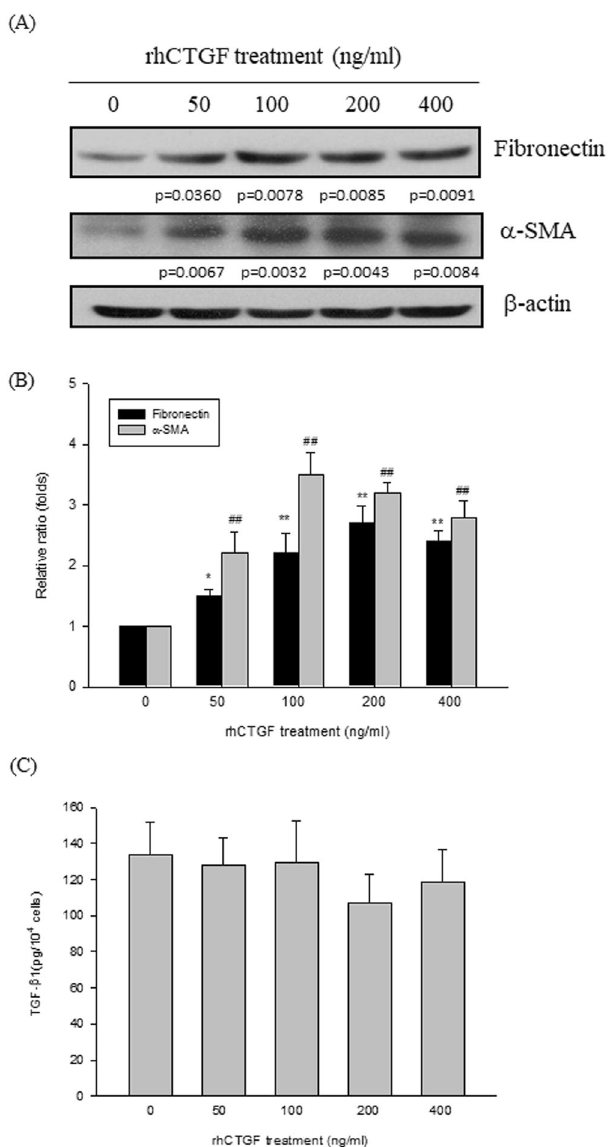
Figure 4. CTGF induced the fibronectin and α -SMA proteins expression in GO orbital fibroblasts. ( A ) After treatment of the orbital fibroblasts from GO1 patient with 50, 100, 200 and 400 ng/ml recombinant human protein CTGF (rhCTGF) for 24 hours, the proteins expression of fibronectin and α -SMA were examined by Western blots. ( B ) The representative bar graphic was constructed by the data obtained from three independent experiments, and data are presented as means ± S.D. ( * p < 0.05; ** and ## p < 0.01). ( C ) By an ELISA kit, the intracellular levels of TGF- β 1 in the orbital fibroblasts from GO1 patient was examined after rhCTGF treatment for 24 hours. The representative bar graphic was constructed by the data obtained from three independent experiments, and data are presented as means ± S.D. ( * p < 0.05 vs. control without rhCTGF treatment; ** ,## p < 0.01 vs. control without rhCTGF